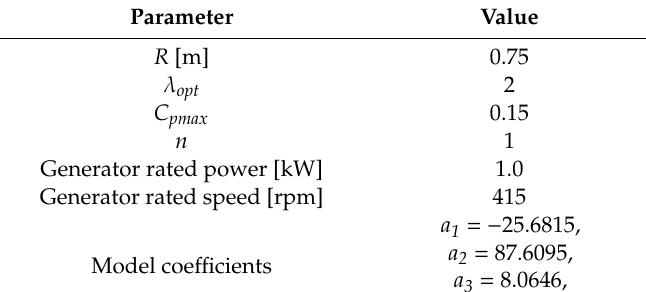
Table 3. Parameters of the considered vertical axis wind turbine.